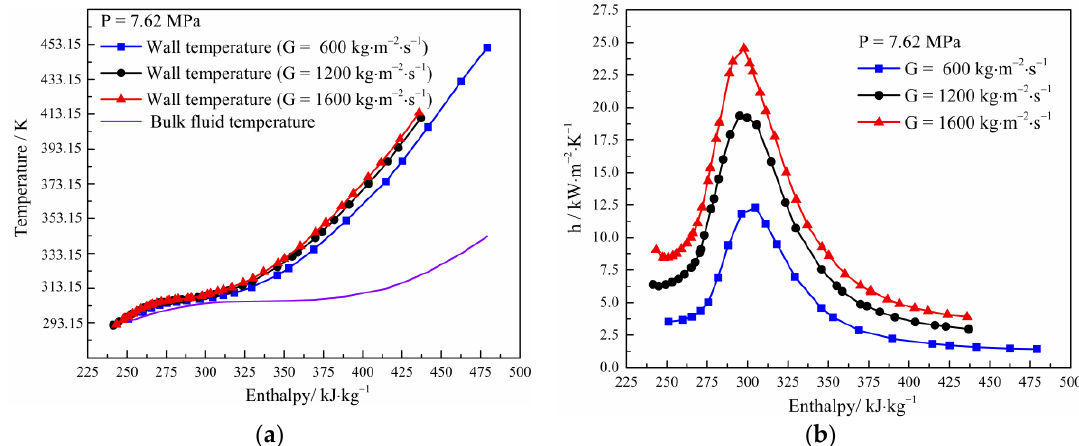
Figure 5. Effect of mass flux on wall temperature ( a ) and heat transfer coefficient ( b ).